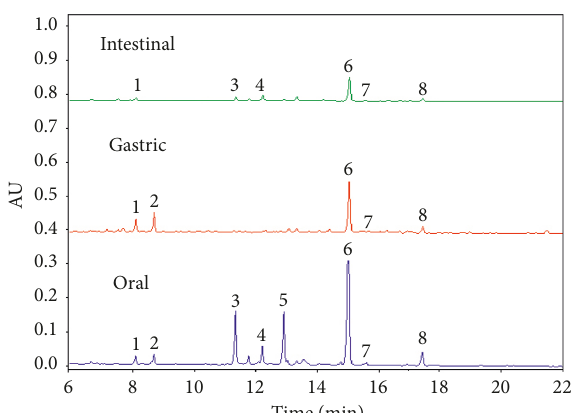
Figure 3: Chromatogram of phenolic compounds in the RTBC during in vitro